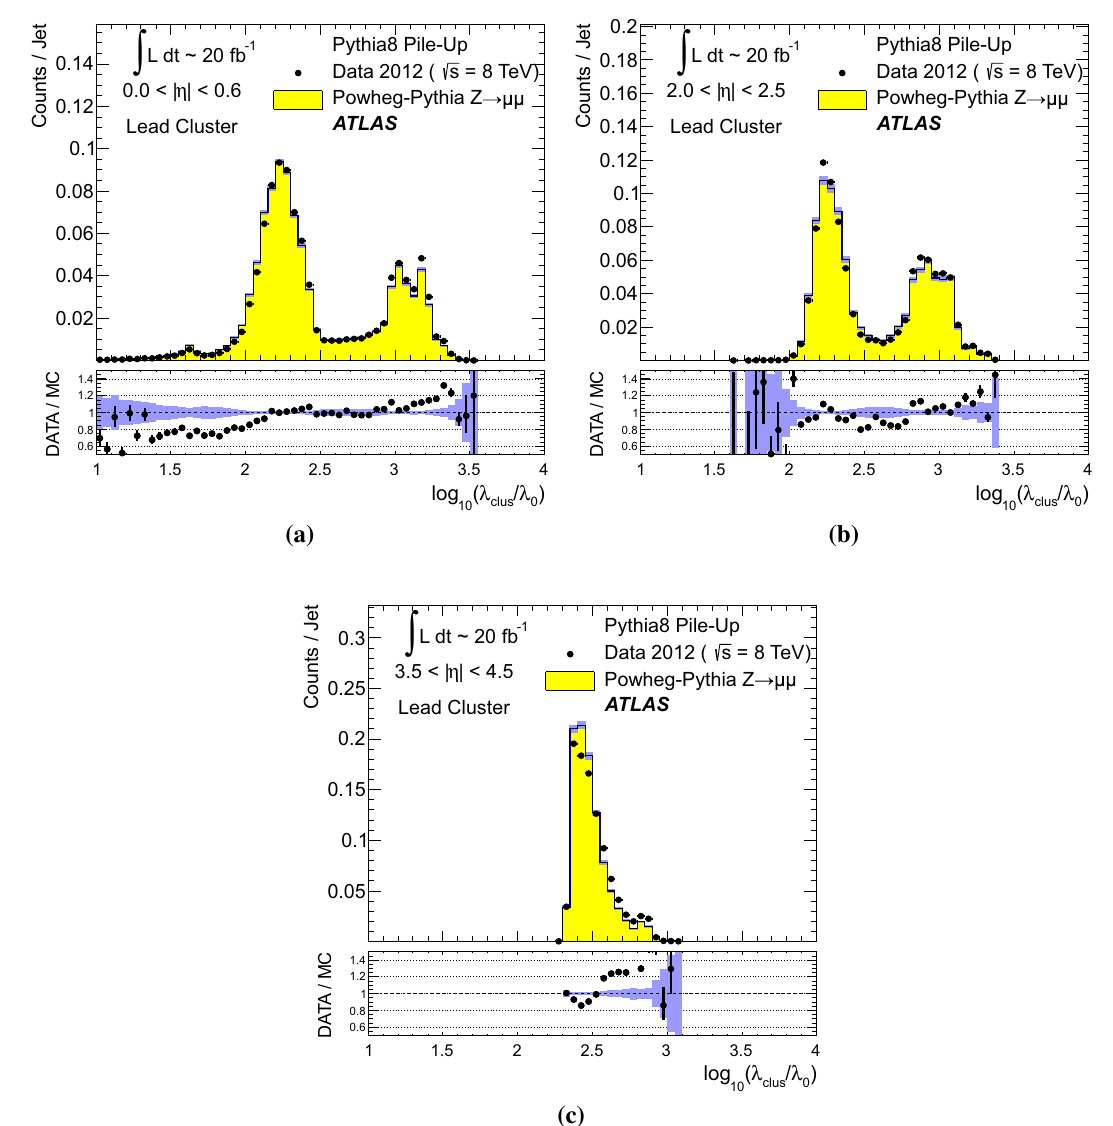
Fig. 36 The distribution of the leading topo-cluster depth location measure log 10 (λ clus /λ 0 ) in fully calibrated jets reconstructed with the anti- k t algorithm with R = 0 . 4 and 30GeV < p LCW + JES 40GeV in regions of a the central ( | η jet | < 0 . 6), b the end-cap (2 . 0 < | η jet | < 2 . 5), and the c forward (3 . 5 < | η jet | < 4 . 5) calorimeters in ATLAS. Data is compared to MC simulations with